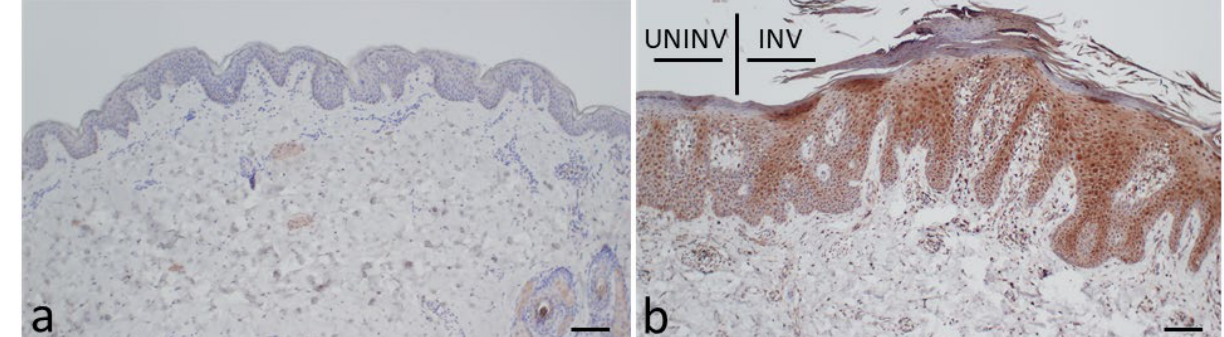
Figure 2. Histological distribution of the expression of kynureninase in psoriasis. (a) The skin from a HC; (b) the skin from a PSO. INV: involved skin; UNINV: uninvolved skin. The tissue sections were stained using the antibodies against kynureninase. Scale bars: 100 μm Cytokine and chemokine concentrations in